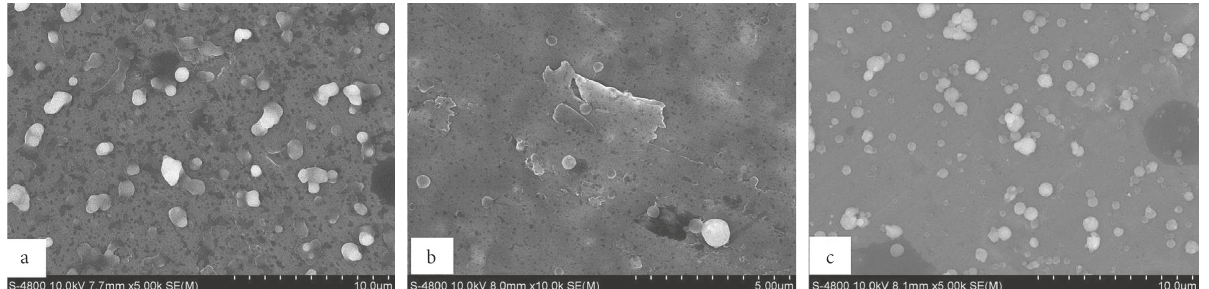
Figure 8: SEM images of the nanoparticles in 1.0 wt.% chitosan concentration at a different voltage (U) and distance (L). (a) M1 chitosan at U 18kV, L 12cm; (b) chitosan at U (cid:30) (cid:30)